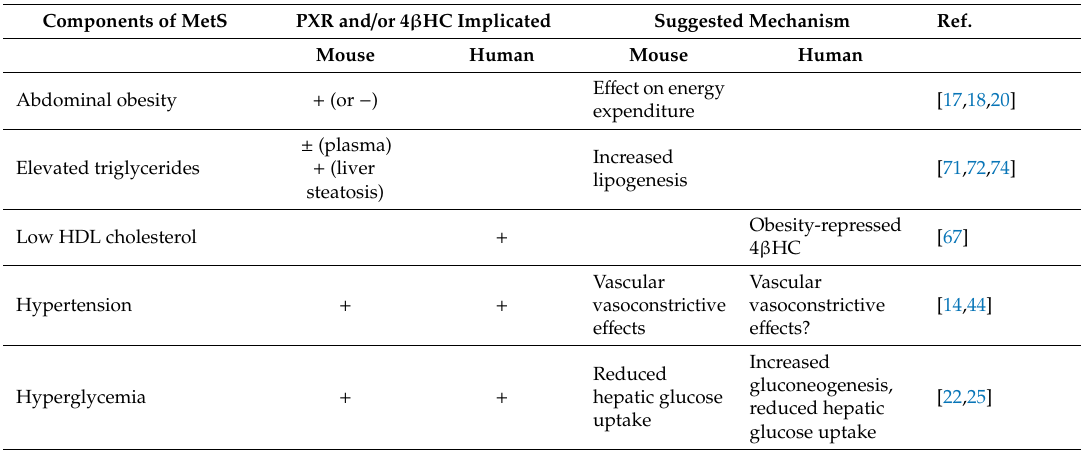
Table 2. Components of the metabolic syndrome and the suggested role of PXR and the PXR–4 β HC axis in mice and